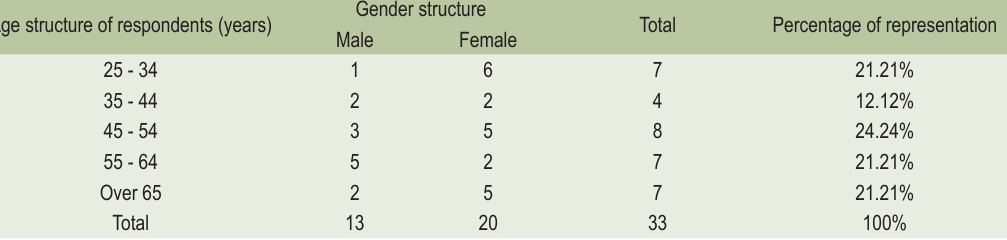
TABLE 2. Gender and age structure of respondents with chronic lumbar pain syndrome Age structure of respondents (years)